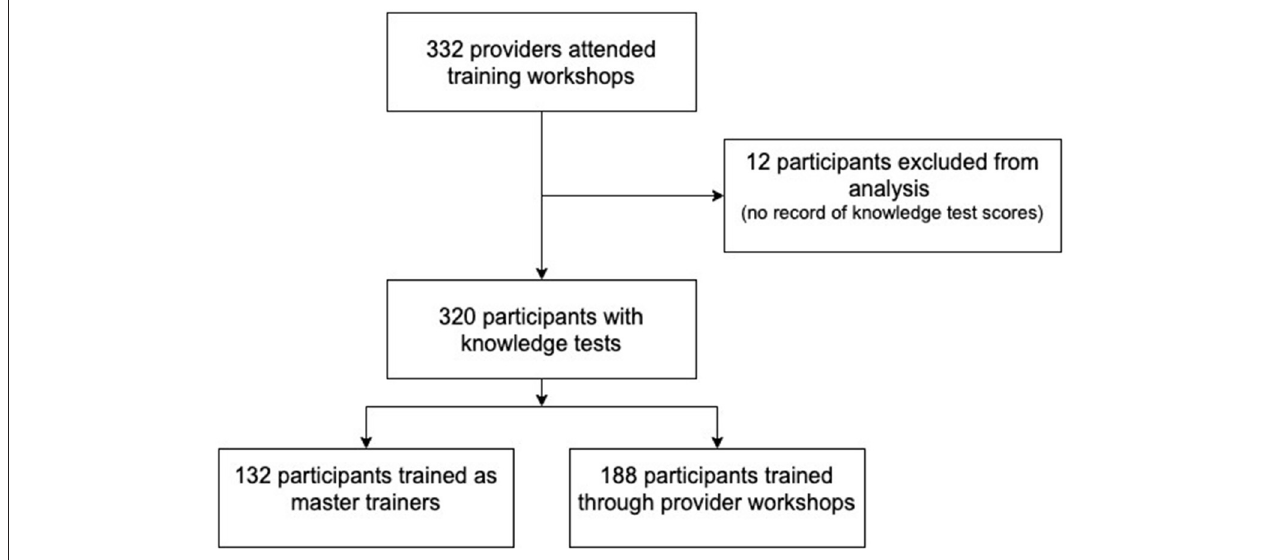
FIGURE 1 | Flow chart of total participants into master trainers vs. general participants.